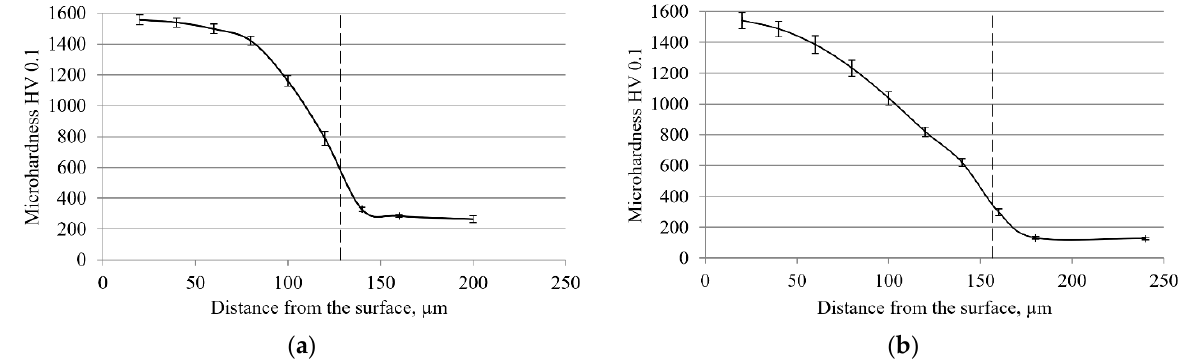
Figure 11. Microhardness curve for layers obtained by boronizing at 920 °C for 6 h: ( a ) C70W2 steel; ( b ) C15 steel.